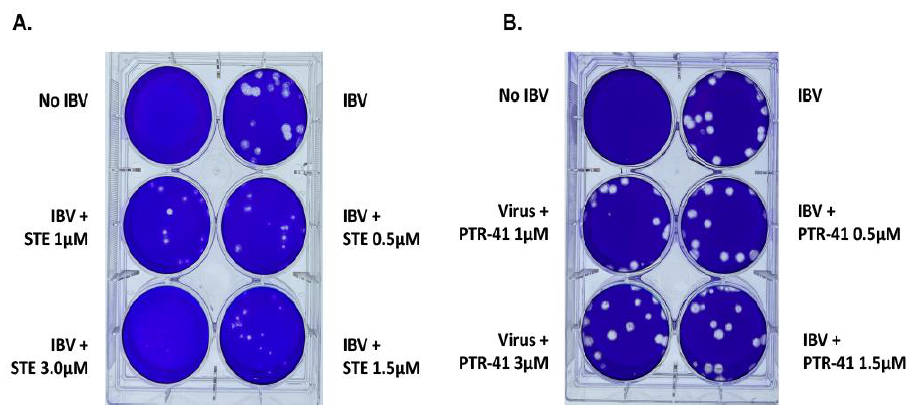
Figure 1. Inhibition of the IBV by the SUMOylation-specific inhibitor, but not the Ubiquitin inhibitor. ( A ) The IBV was inhibited by the specific SUMOylation inhibitor, STE025, in a dose-dependent manner. The MDCK cells were infected with IBV viruses for three days before the plaque staining.